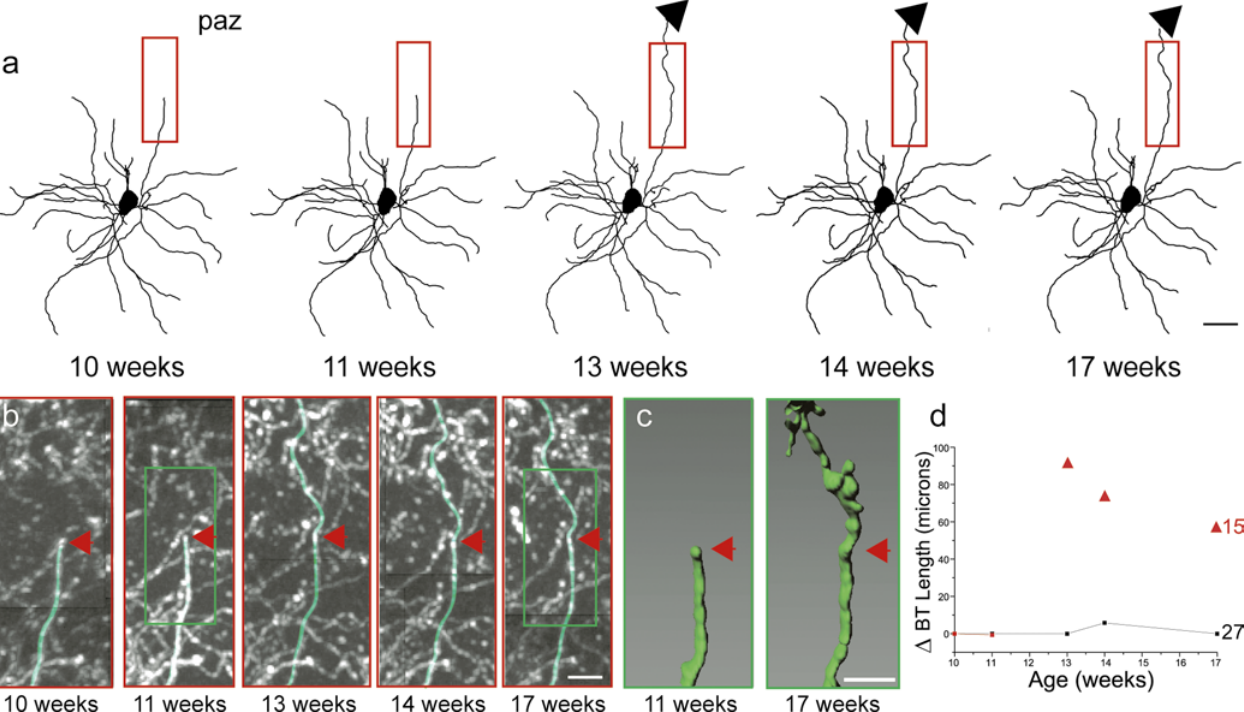
Figure 4. Large-Scale Dendritic Branch Growth in a Non-Pyramidal Neuron (A) Three-dimensional skeletal reconstructions of the non-pyramidal neuron ‘‘ paz ’’ from images acquired over 7 wk. Note that a growing branch tip exceeded the imaging volume after 11 wk, and black arrowheads denote its postulated continuation. (B) MZPs of region outlined by red box in (A). The branch tip (#15) elongates radially in the x–y -axis and away from the pial surface in the z -axis. Non- specific labeling in the MZP is exacerbated by the summation of additional z stacks due to elongation on the z -axis. The traced branch of interest is highlighted by a green overlay. Red arrowheads mark the approximate distal end of the branch tip at 11 wk. (C) Three-dimensional isosurface reconstructions of the region of the branch tip outlined by a green box in (B). (D) Plot of change in BTL of dynamic branch tips as a function of age. Triangles denote the minimum length of the branch tip as it exceeds the border of the imaging volume. Number to the right denotes branch tip number. Scale bars: (A), 25 l m; (B and C), 10 l m. DOI: 10.1371/journal.pbio.0040029.g004 PLoS Biology |